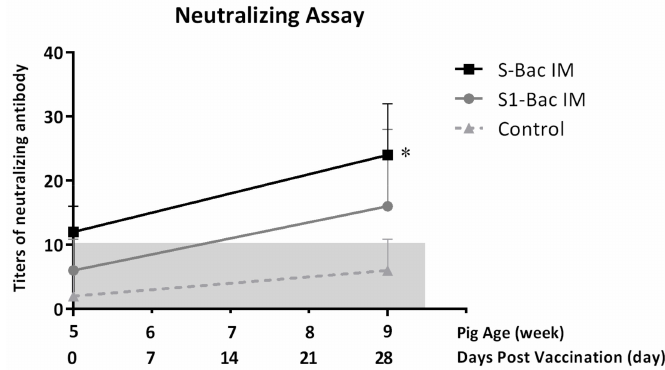
Figure 8. The neutralizing titers against porcine epidemic diarrhea virus (PEDV) in each group at day 0 (pre-priming) and day 28 (2 weeks post-boosting). A solid line with square icons, a gray line with round icons, and a dotted line with triangle icons represent the titers of anti-PEDV neutralizing antibodies of pigs in the S-Bac, S1-Bac, and control groups, respectively. Values are presented as means ± SD. The gray zone represents the background of the neutralizing assay. *: significant difference with the control group ( p < 0.05).